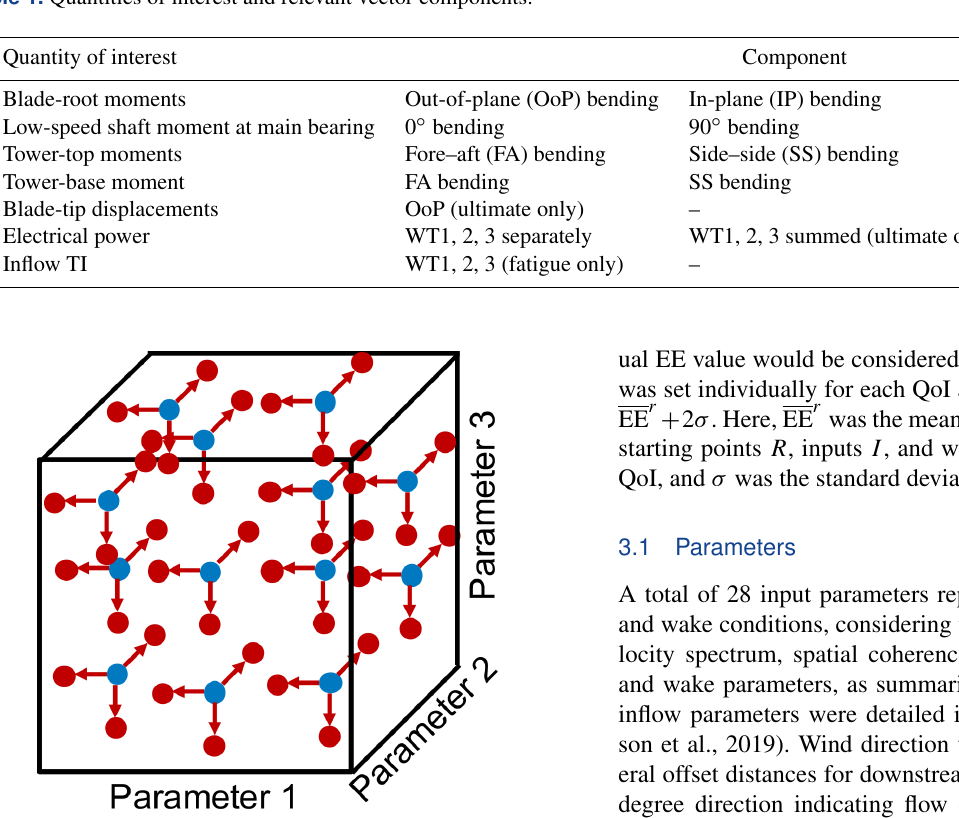
numbers (blue circles in Fig. 3), which ensures a wide sam- pling of the input